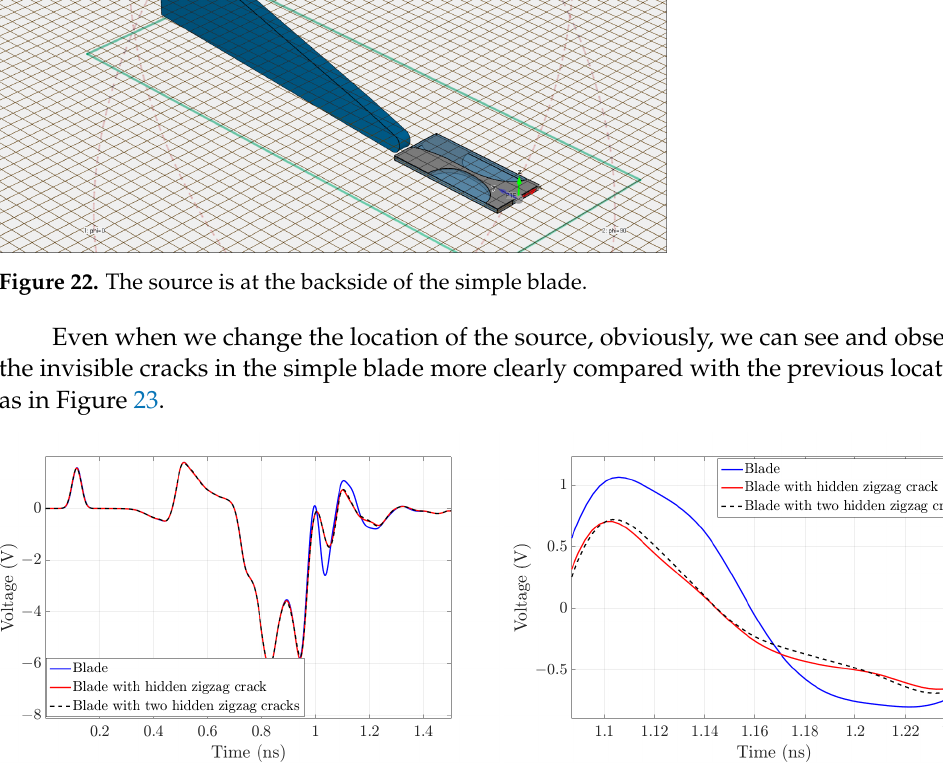
Figure 23. The difference in the amount of reflected voltage between the simple blade without cracks, with one invisible zigzag crack, and with two cracks.